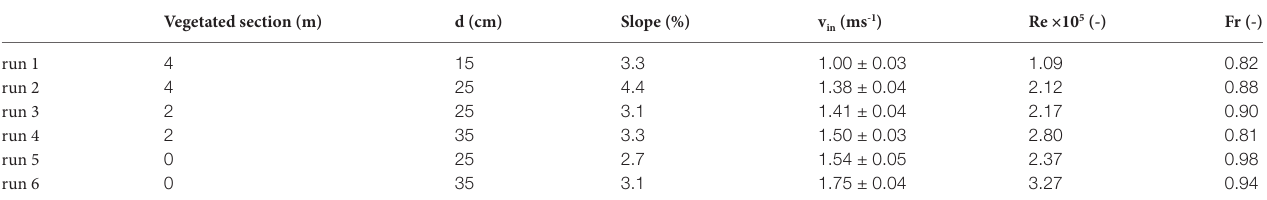
TABLE 1 | Overview of the six experimental runs with varying vegetation cover (m), water depth ( d , cm), water surface slope (%), flow velocities ( v in , ms -1 ), Reynolds ( Re ) and Froude ( Fr ) numbers within the vegetation test section. Vegetated section